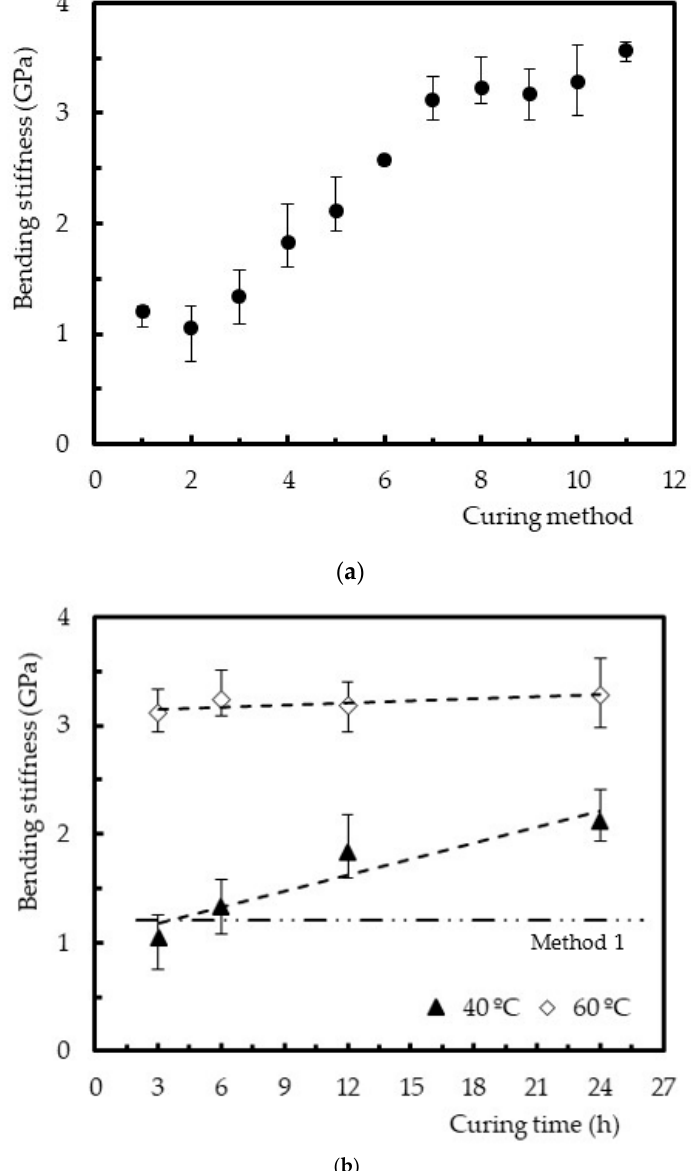
Figure 8. ( a ) Effect of the curing parameters on bending stiffness and ( b ) effect of the post-cure on Figure 8. ( a ) E ff ect of the curing parameters on bending sti ff ness and ( b ) e ff ect of the post-cure on bending stiffness. bending sti ff